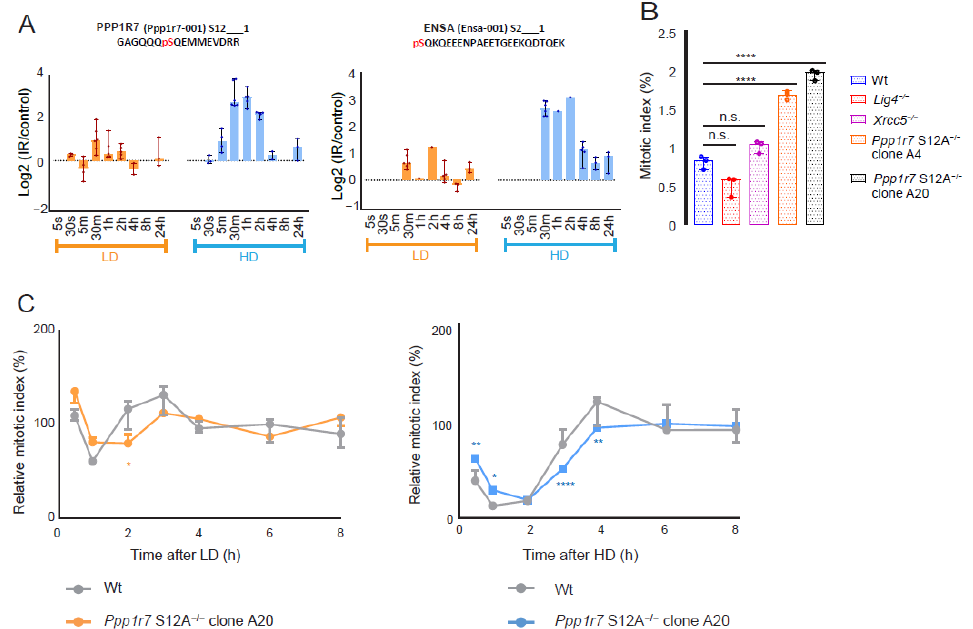
Figure 5. Phospho-S12 PPP1R7 signaling dynamics, mitotic exit, and checkpoint activation in mESCs: ( A ) Dynamics of PPP1R7 pS12 and ENSA pS2 in response to LD and HD. ( B ) Mitotic index (in % of metaphase cells among total population in the absence of exogenous DNA damage) of five different cell lines: wt, Lig4-/-, Xrcc5-/-, Ppp1r7 S12A-/- (clone A4) and Ppp1r7 S12A-/- (clone A20) cells. Statistics: one-way ANOVA test between wt and other cell lines. (**** p -value < 0.001; n.s. = not significant). ( C ) A kinetic plot of the relative mitotic index of wt (in grey; data are taken from Figure 4C) and clone A20 cells in response to LD (in orange) and HD (in blue). Dots and error bars represent median and 95% CI values, respectively. Statistics: two-way ANOVA with a post hoc Dunnett’s test at 95% CI between wt and clone A20. (* p -value < 0.05, ** < 0.01 and **** < 0.0001).